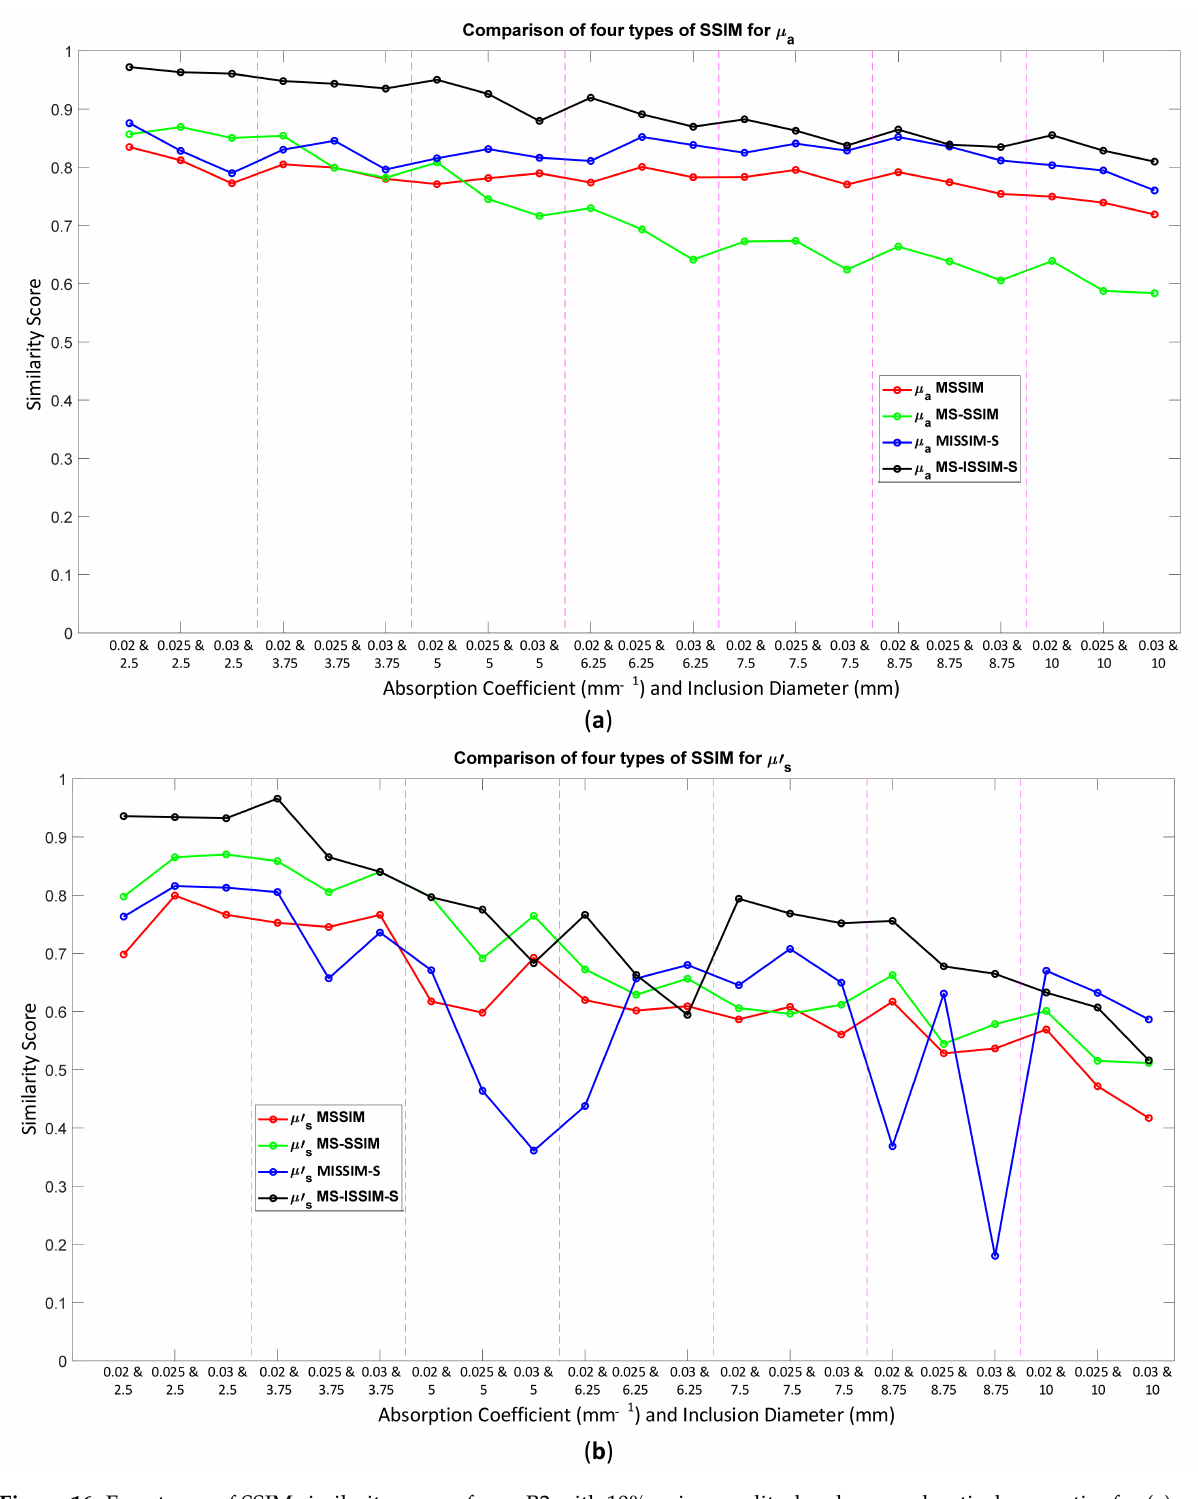
Figure 16. Four types of SSIM similarity score of case B2 with 10% noise amplitude, phase, and optical properties for ( a ) µ a and ( b ) µ (cid:48) s